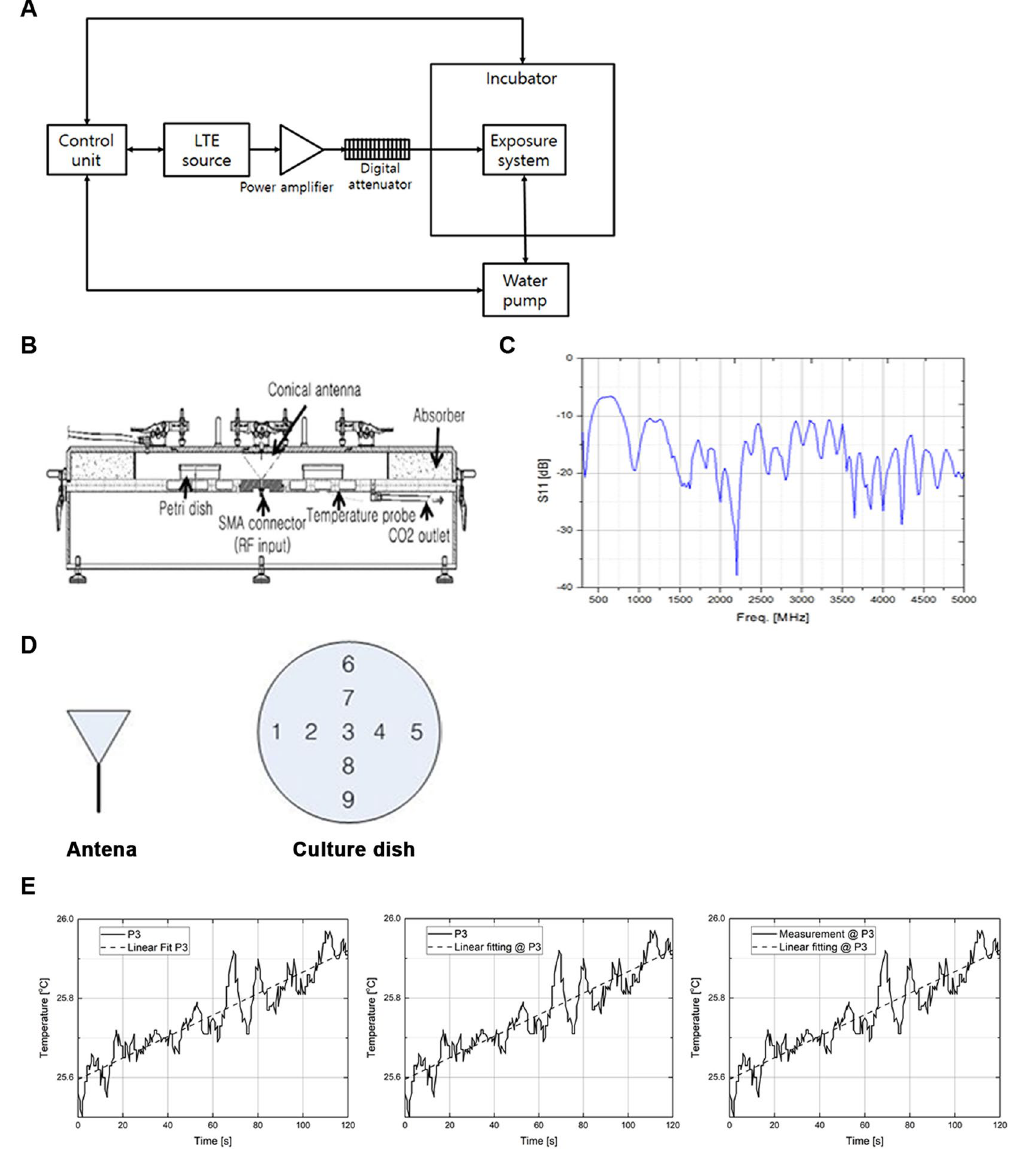
Figure 1. Design of the 1.7 GHz LTE RF-EMF cell exposure system. ( A ) A schematic diagram of the radial transmission line (RTL) exposure system. ( B ) Cross-sectional view of the RTL exposure chamber. ( C ) Return loss characteristics of the RTL exposure chamber. ( D ) Antenna and the measurement points in each culture plate. ( E ) Temperature and linear fitting for the center point at the LTE 1.7 GHz frequency. Temperature was measured without circulating water during RF